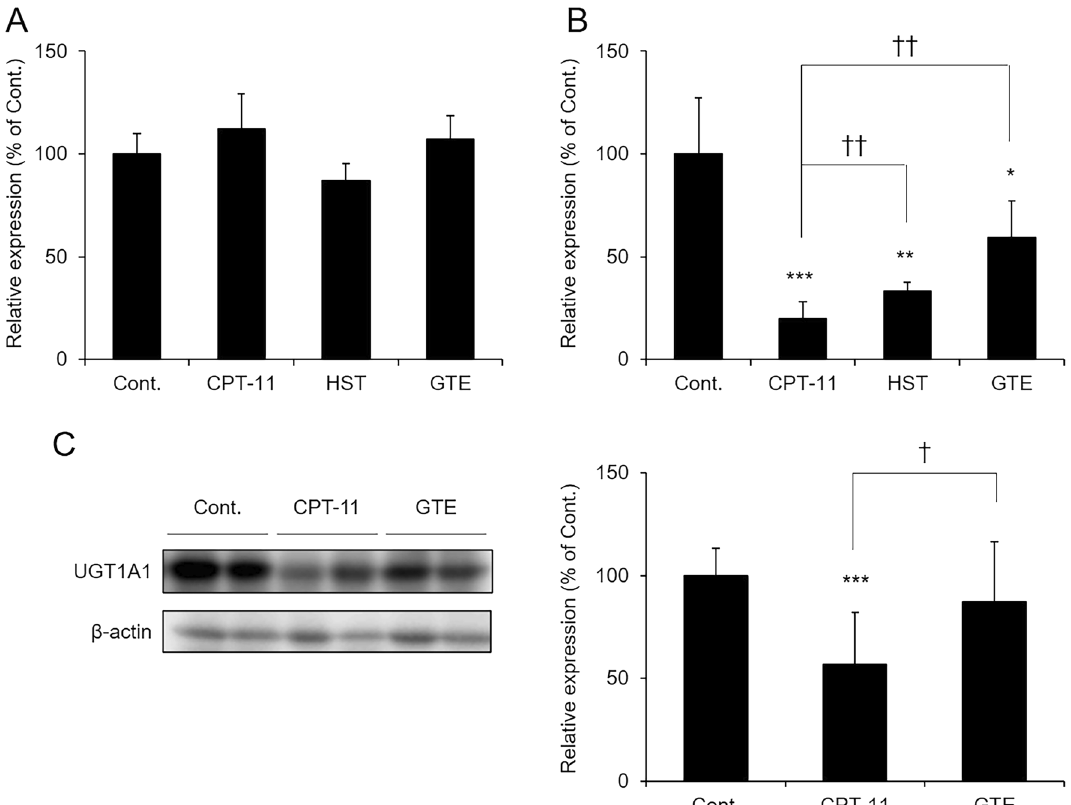
Figure 3. Changes in intestinal UGT1A1 expression after CPT-11 and GTE treatment. Rats were administered CPT-11 or lactic acid buffer intravenously for 4 days, and HST or GTE was administered in combination. The mRNA and protein expression levels of UGT1A1 in the small intestine ( A ) or colon ( B or C ) were analyzed by real-time PCR or Western blotting. Each value was normalized using β-actin levels and is shown as 100% of the mean value in the control group (mean ± S.D., n = 5, * p < 0.05, ** p < 0.01, *** p < 0.001 vs. Cont., † p < 0.05, †† p < 0.01 vs.